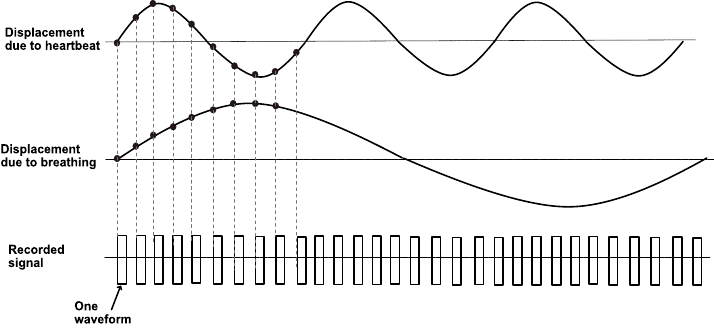
Figure 1. Signal recording in relation to the breathing and heartbeat rhythm.